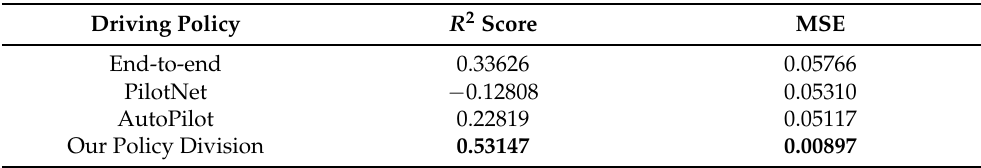
Table 6. Comparison of the proposed method versus end-to-end methods. The best results are remarked in bold font.